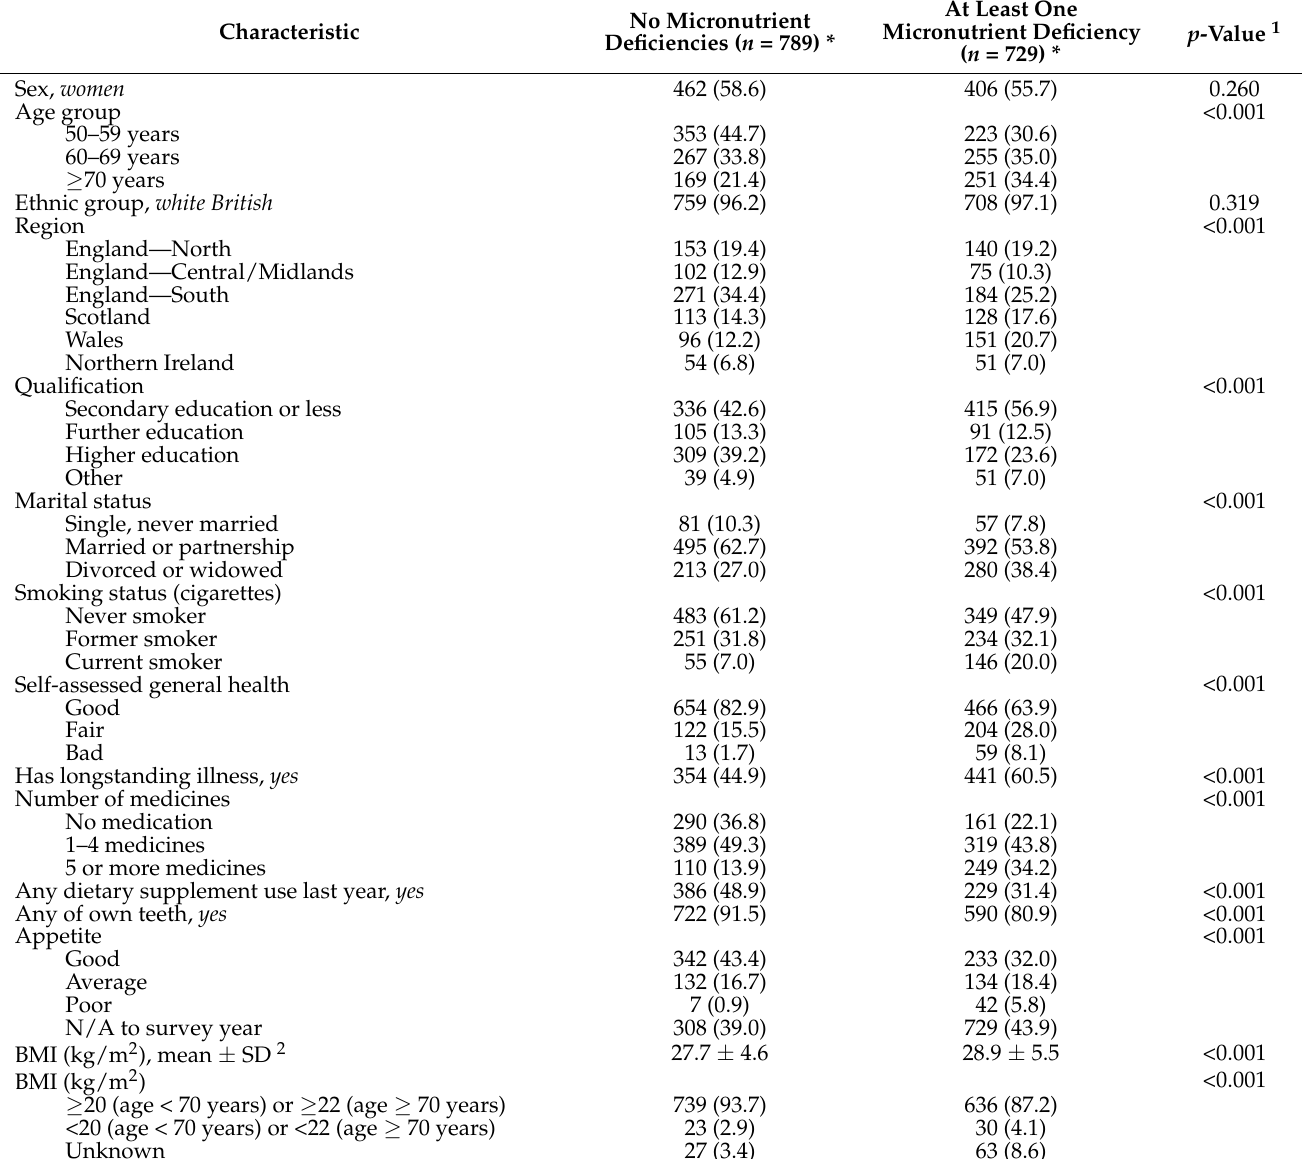
Table 1. Characteristics of study population according to micronutrient deficiency biomarker status (vitamin B 6 PLP, vitamin B 12 , vitamin C and selenium, zinc) ( n =